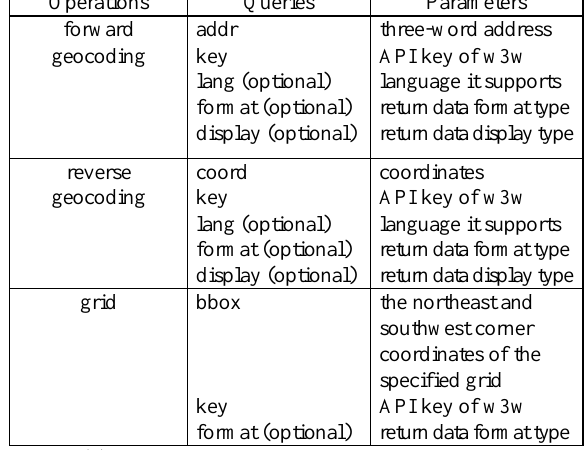
Table 2 (b) Example URIs’ parameters of w3w RESTful API